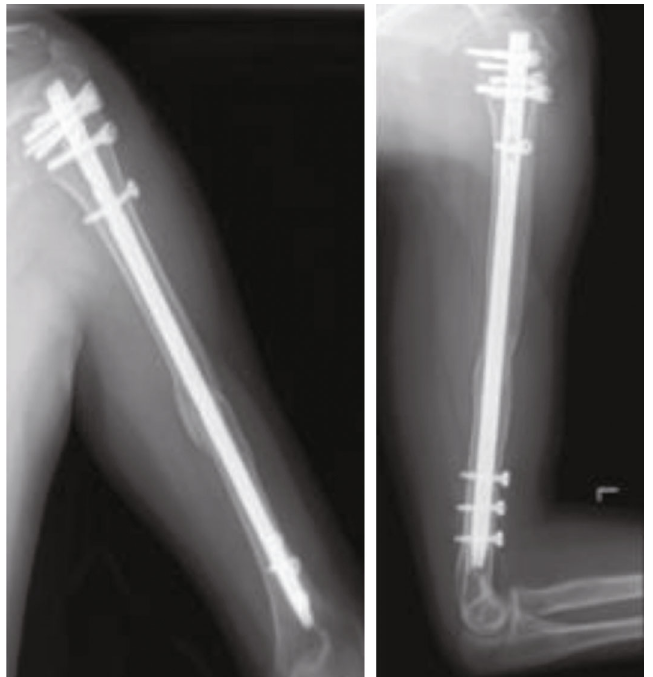
Figure 7: Radiographs at 7 months after the surgery. Bony union was obtained. At 15 months after the second surgery, we performed surgery to remove all implants including the screws and the nail.